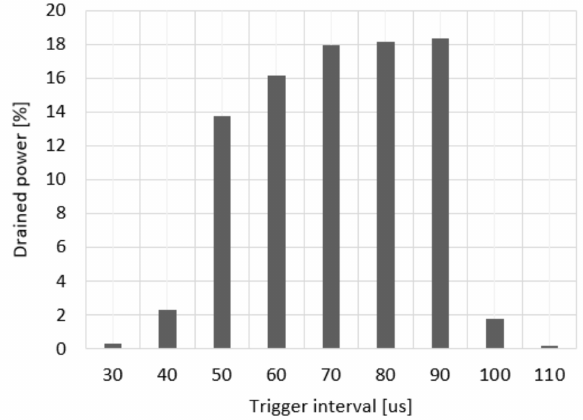
Figure 7. Triggering interval vs. battery drained